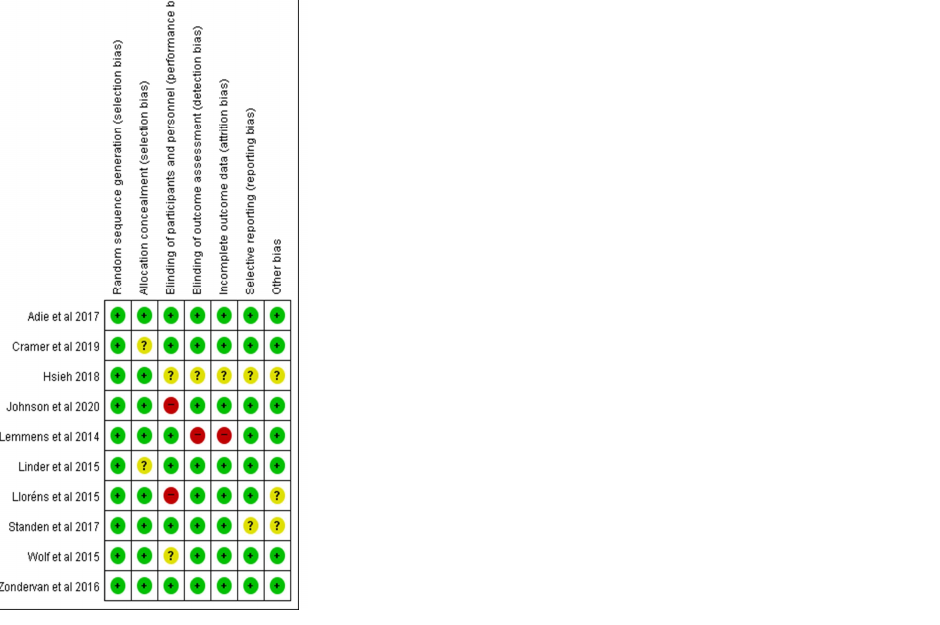
Figure 2. Risk of bias for 10 studies (green; low risk, yellow; unclear, red; high risk) [12–21].